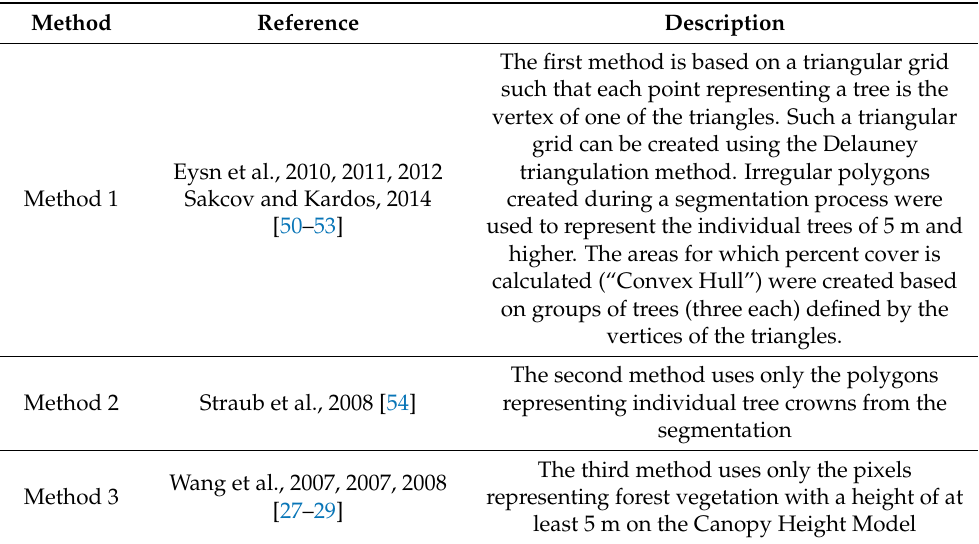
Figure 5. Area for which the percentage cover is calculated: Method 3 [27–29]. Table 4. The summary of the three methods.